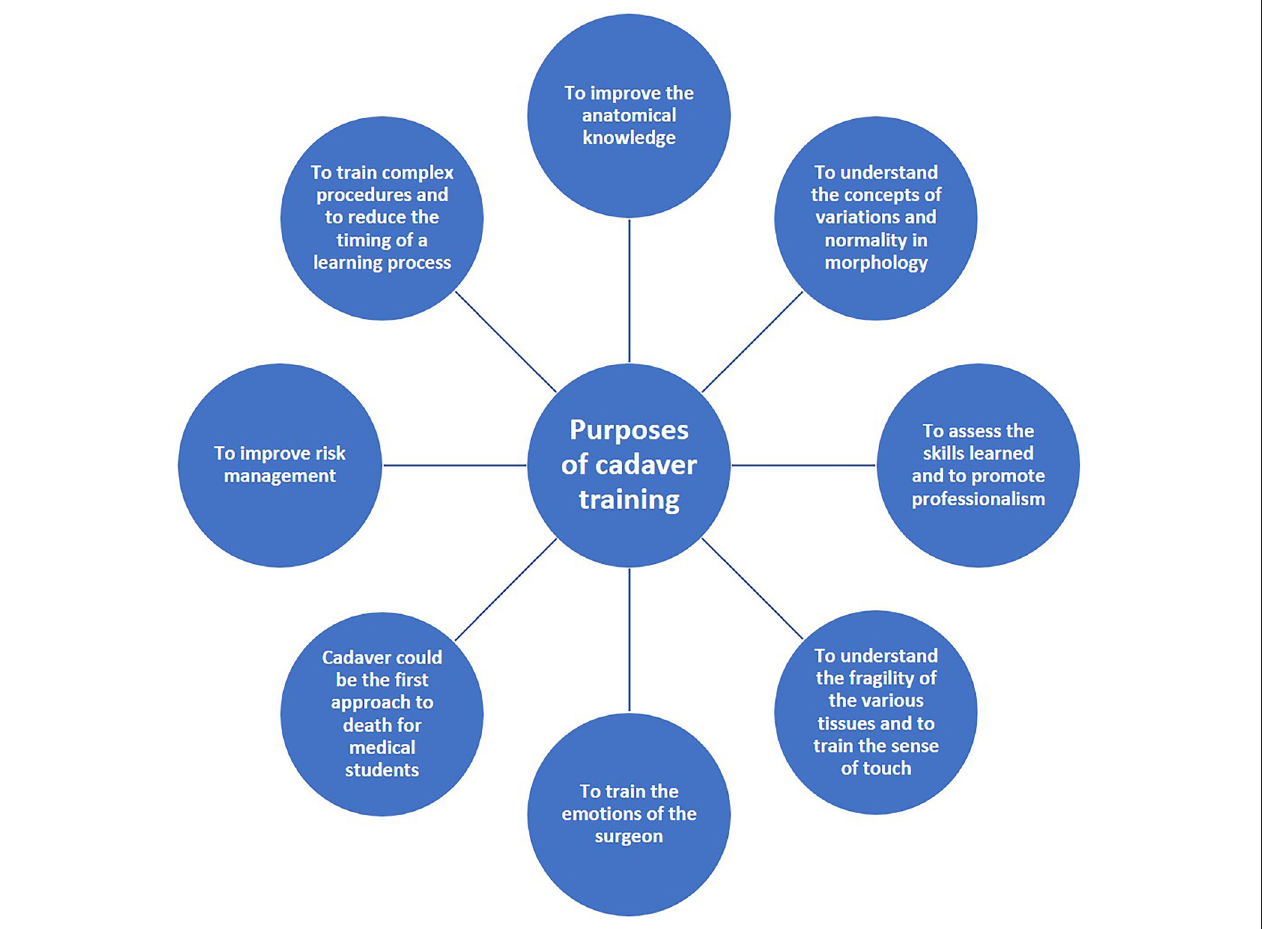
FIGURE 2 | Summary of purposes of cadaver